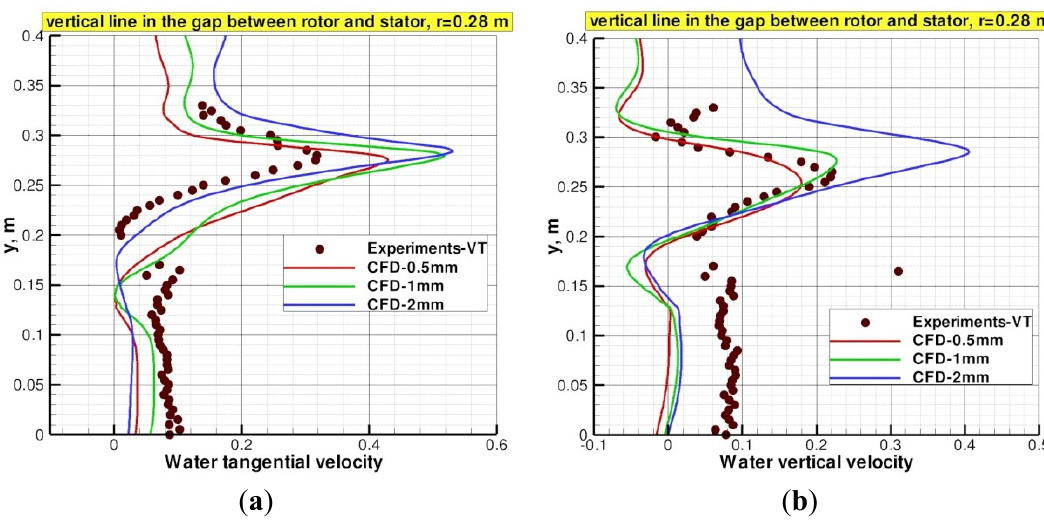
Figure 9. ( a ) Normalized water superficial tangential velocity on a vertical line r = 0.28 m in the gap between the rotor and the stator and ( b ) normalized water superficial vertical velocity on a vertical line r = 0.28 m in the gap between the rotor and the